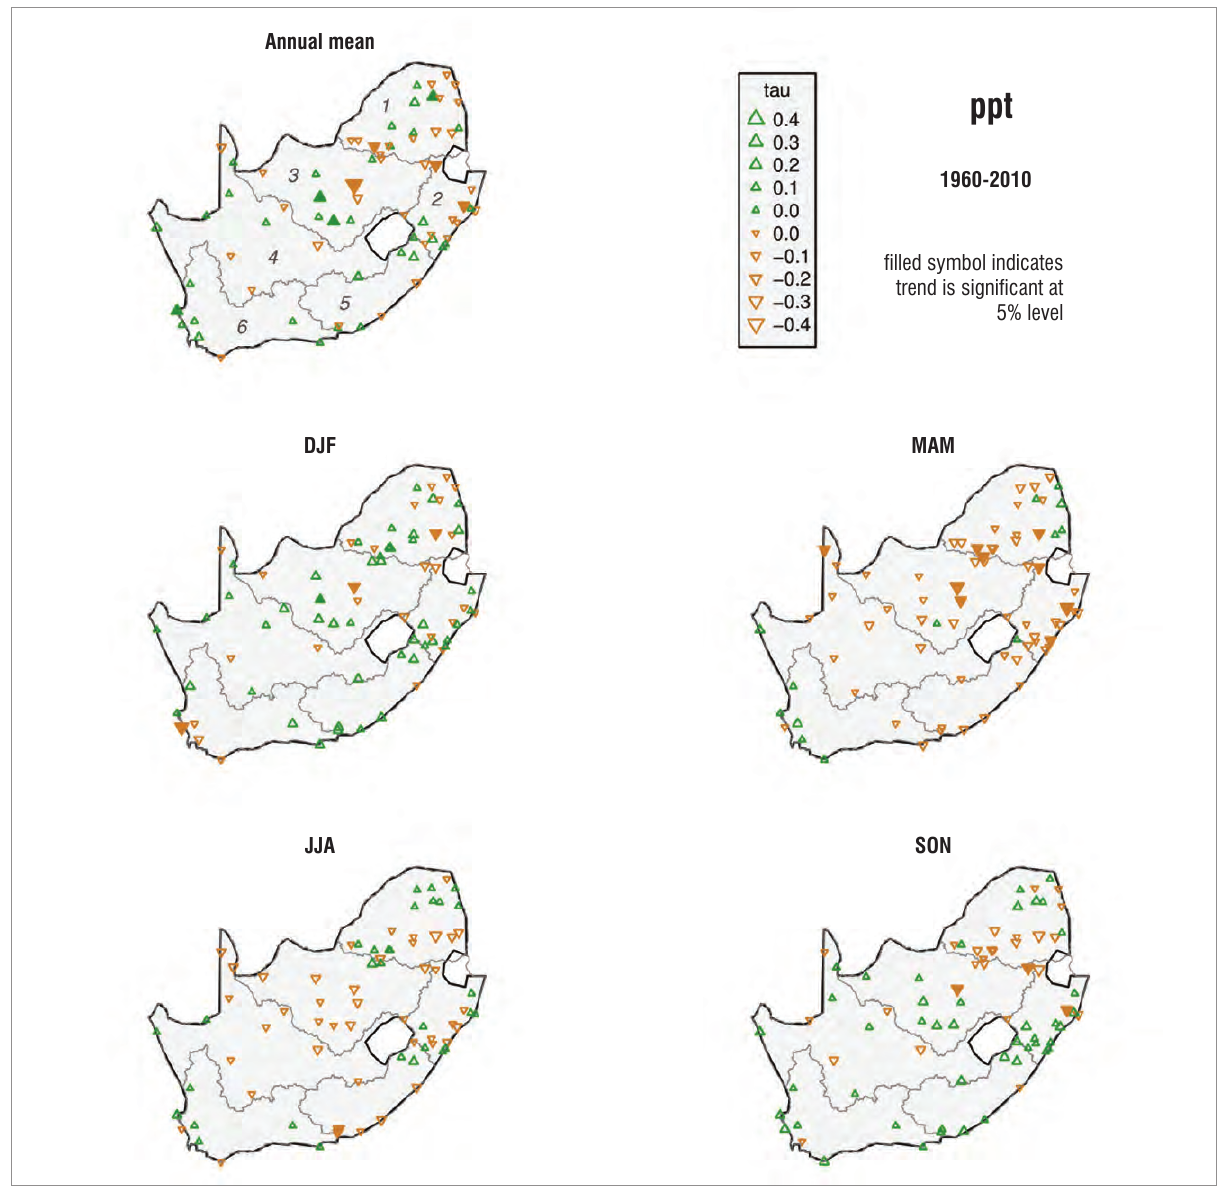
Figure 1: Trends in annual and seasonal mean rainfall (ppt) for each station according to the Mann–Kendall test. The value of tau represents the direction and relative strength of the trend. Shaded symbols denote trends that are significant at the 5% level. Seasons are summer (DJF), autumn (MAM), winter (JJA) and spring (SON). Grey borders represent boundaries of the six water management regions, which are identified by number (1–6) in the annual mean